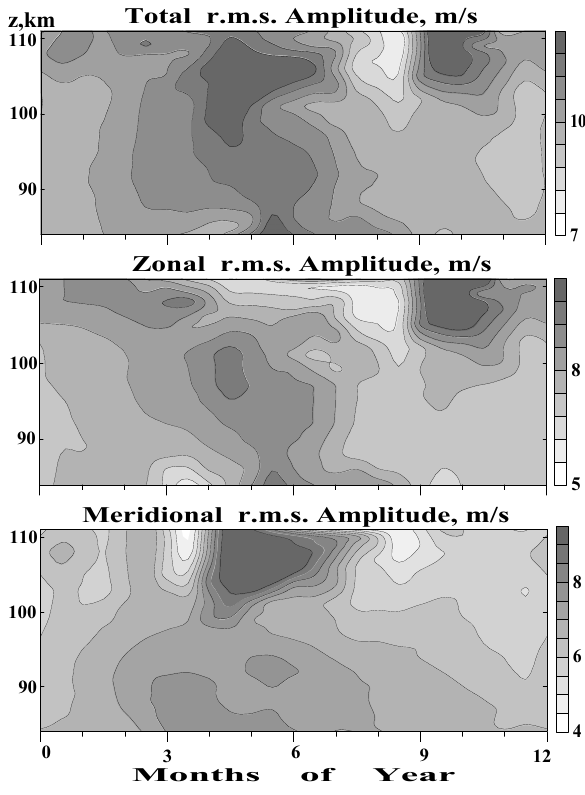
Fig. 1. “Gavrilov and Jacobi, A study of seasonal…” Fig. 1. Standard deviations of ionospheric drift velocity perturba- tions with periods 0.7–3h averaged for each respective month over years